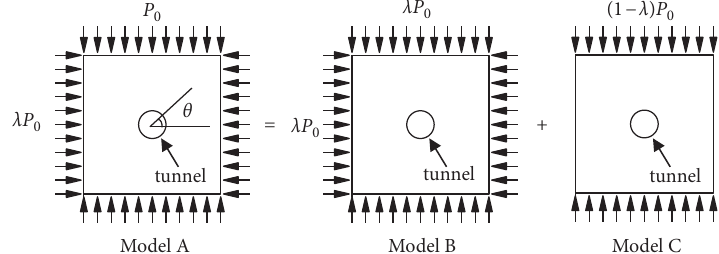
Figure 1: The mechanical model of the circular tunnel under nonaxisymmetric in situ stress